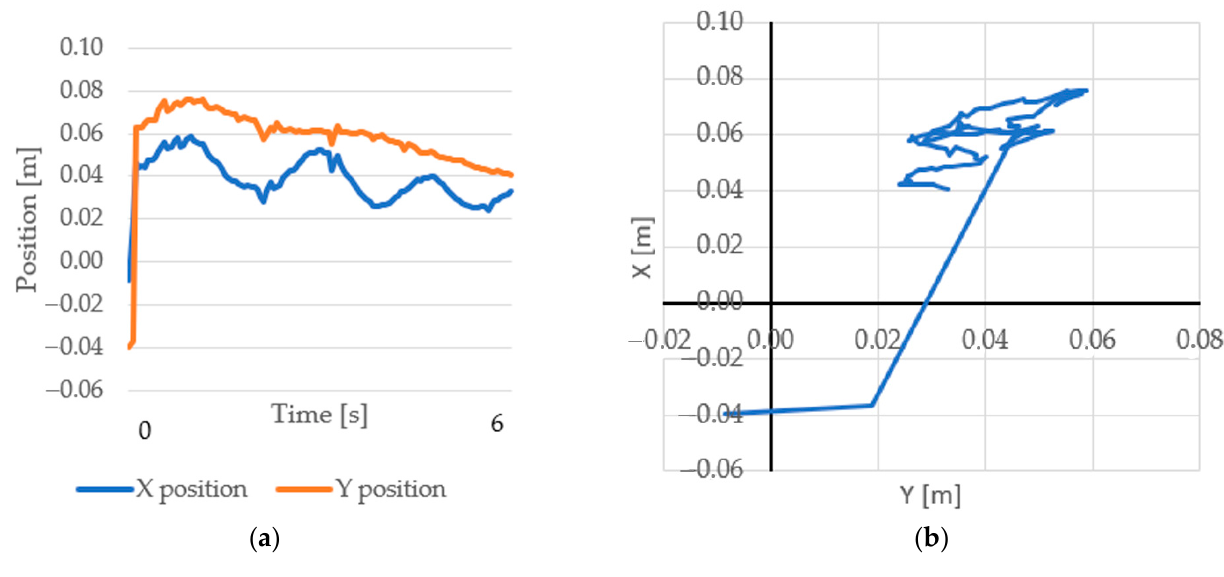
Figure 12. ( a ) Example run: X and Y positions in the real environment using a virtually trained agent. ( b ) Positions in 2 dimensions.